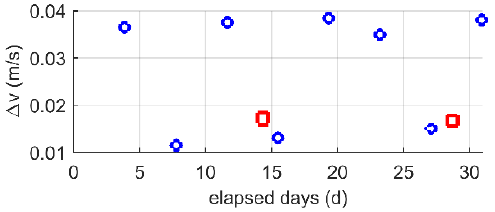
Figure 6. Δ(cid:1874) required for maintenance of safety tube ‐ based formations over the first 30 days of Figure 6. ∆ v required for maintenance of safety tube-based formations over the first 30 days of mission— (cid:1860) (cid:3404) 550 km, (cid:1856) (cid:3051)(cid:3053) (cid:3404) 20 (cid:1865) , no navigation errors. Blue circular markers refer to the LI sce ‐ mission— h = 550 km, d xz = 20 m, no navigation errors. Blue circular markers refer to the LI scenario, nario, while red square markers to the SS scenario. while red square markers to the SS scenario.